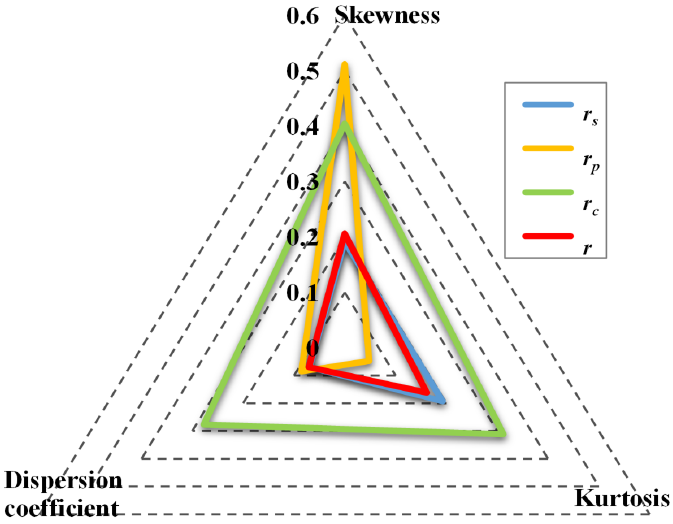
Figure 9. Radar chart of skewness, kurtosis, and dispersion coefficient of r, as well as r s , r p , and r c .